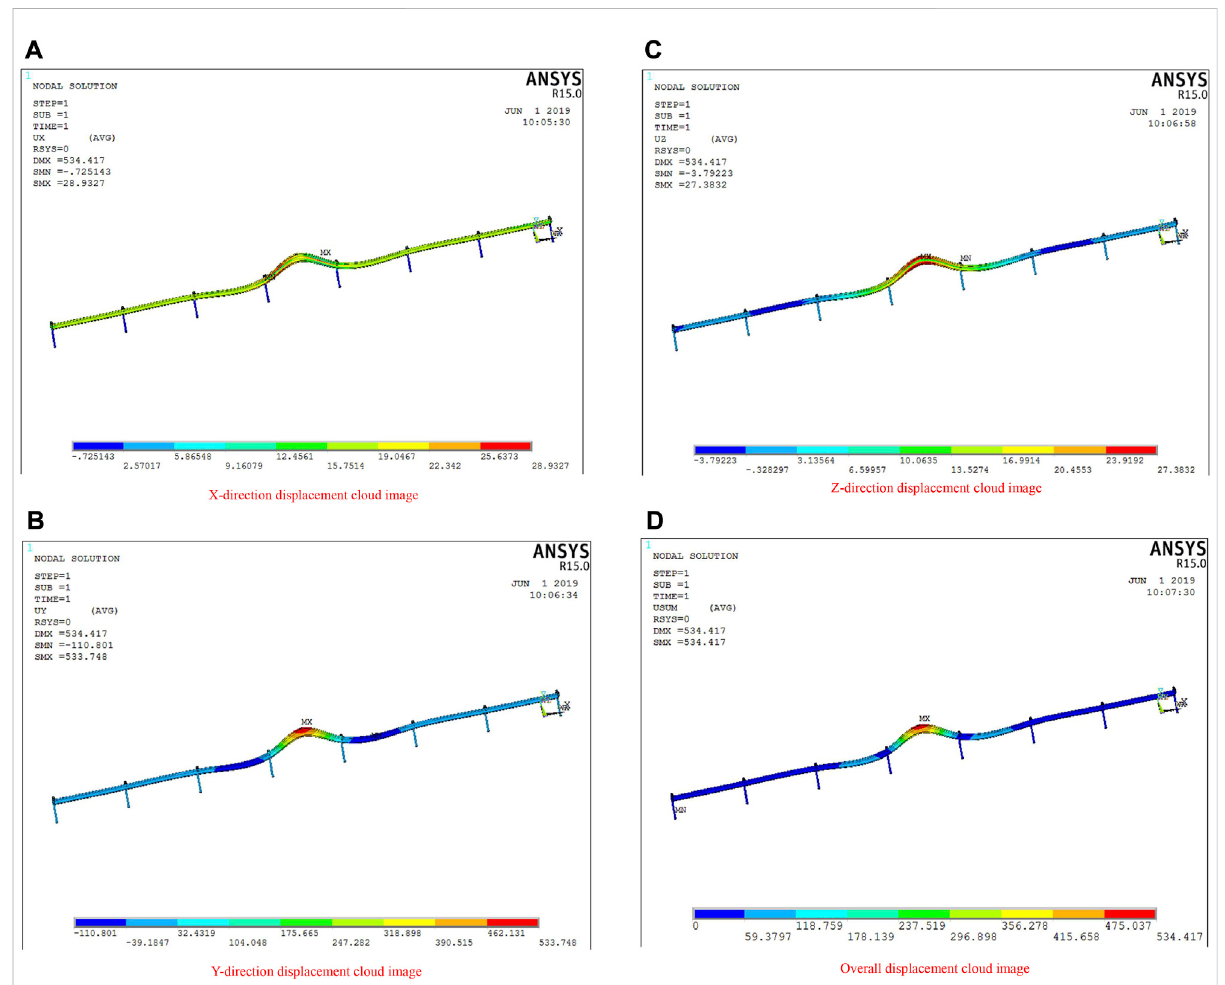
FIGURE 6 Displacementclouddiagramofathree-wave beamsteelguardrail(impactedbythe25-textra-largebusatthespeedof85 km/hfromanangle of 20 ° , the concrete-embedded post). (A) : X-direction displacement cloud image of three-wave beam steel guardrail. (B) : Y-direction displacement cloud image of three-wave beam steel guardrail. (C) : Z-direction displacement cloud map of three-wave beam steel guardrail. (D) : Overall displacement cloud image of three-wave beam steel